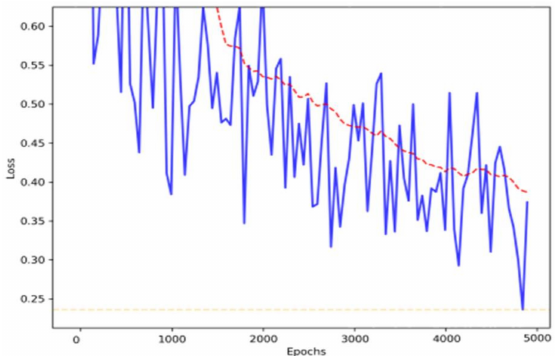
Figure 10. Loss function after training SIMRDWN